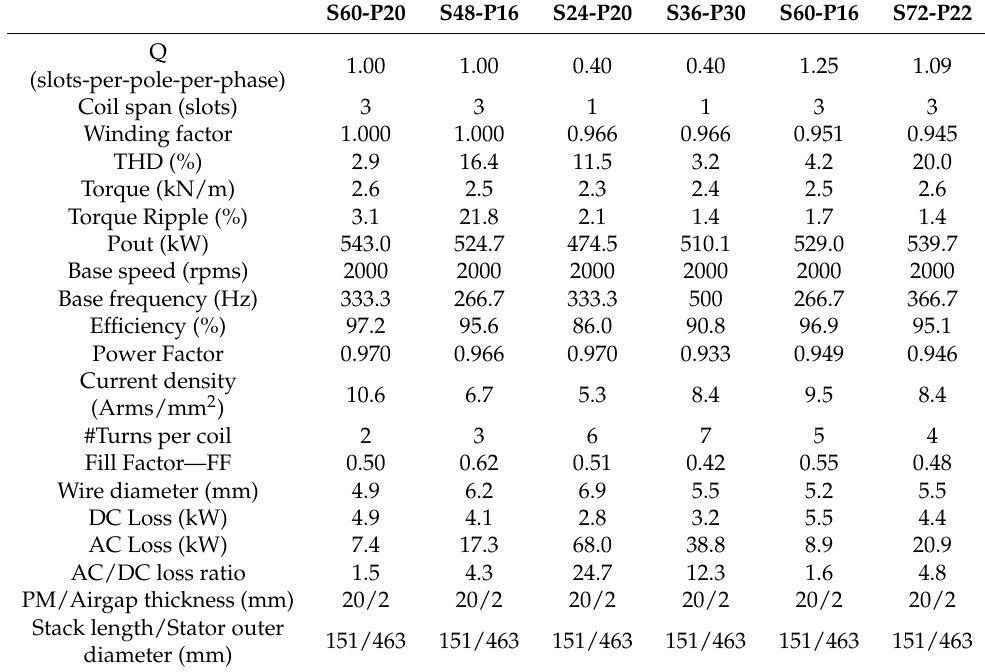
Table 1. Motors were considered for the AC winding losses